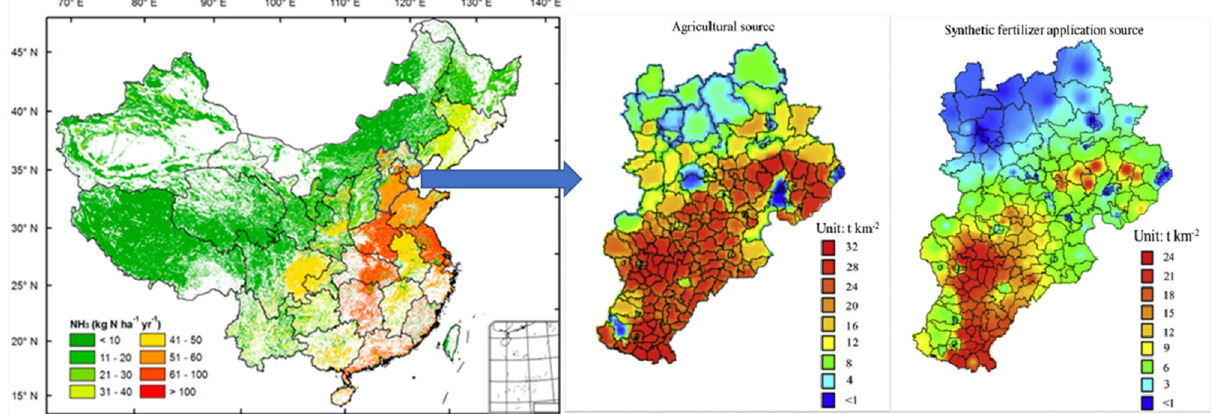
Figure 1. The spatial distribution of NH 3 emissions in China [29] and the spatial distribution of agricultural and synthetic fertilizer application sources in the Beijing-Tianjin-Hebei region [72].